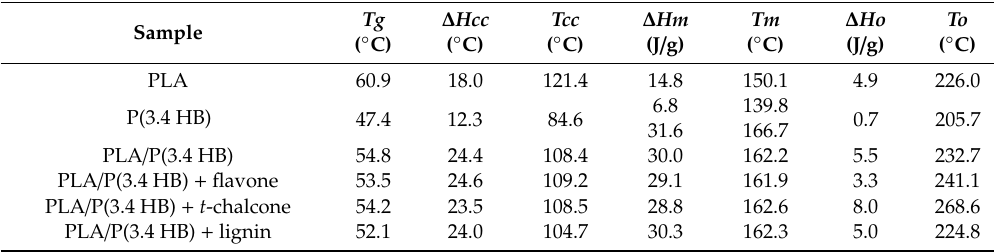
Figure 1. DSC curves of PLA/P(3.4 HB) composites with selected natural antioxidants in comparison to reference PLA, P(3.4 HB), and PLA/P(3.4 HB) samples. Table 2. Differential scanning calorimetry (DSC) analysis of PLA/PHB samples contained selected antioxidants.